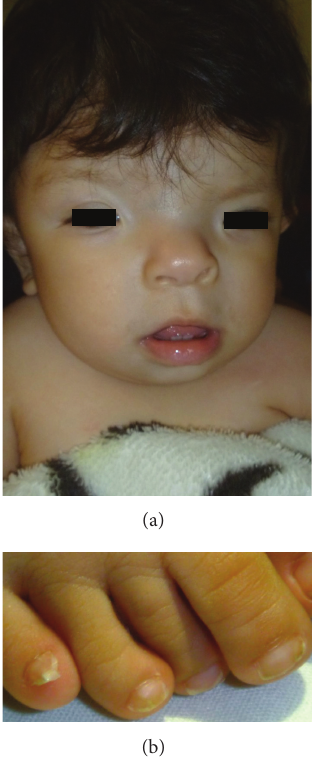
Figure 1: (a) Patient’s facial appearance. Hypertelorism, broad and flattened nasal bridge, and bifid nasal tip are evident. (b) Broad toes with longitudinally split nails can be observed.